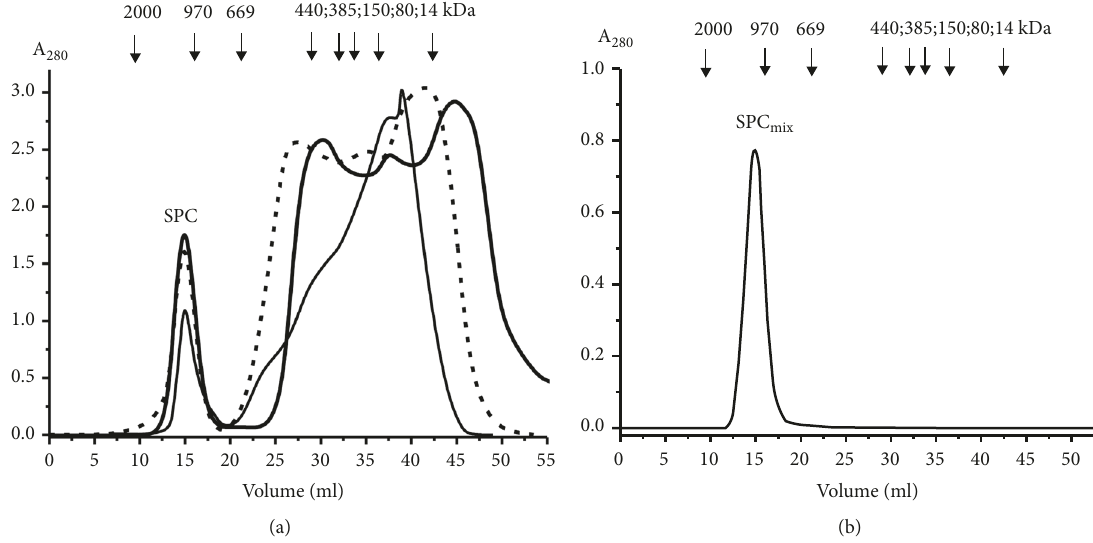
Figure 2: Isolation of milk very stable protein complex (SPC) by gel filtration on Sepharose 4B (50 mL) of fresh human milk (1 mL) of three donors. (a) Rechromatography of equimolar mixture of complexes from nine milk preparations (SPC mix ) on Sepharose 4B. Lines of three profiles of Panel (a) and one profile of Panel (b) correspond to absorbance at 280 nm (A 280 ).